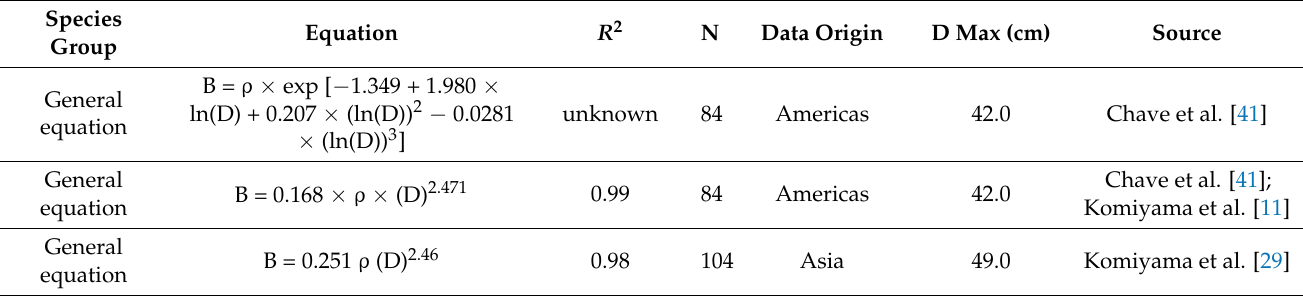
Table A1. List of allometric equations for estimating aboveground biomass (ABG) by using DBH (D), height (H) and wood density ( ρ